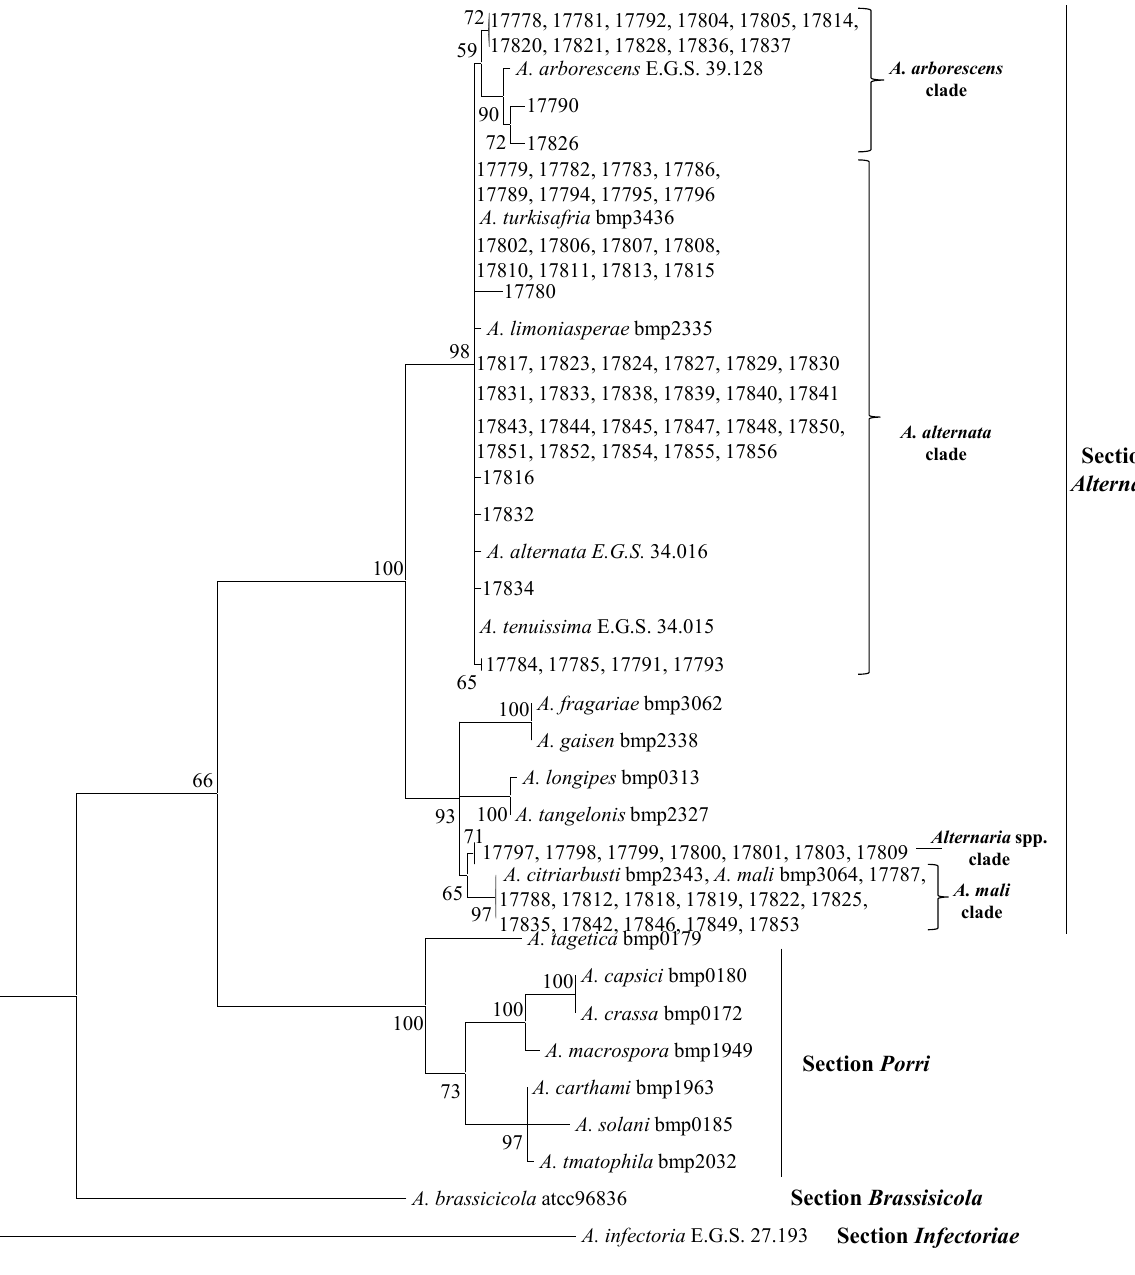
Figure 2. Phylogenetic tree generated by the Maximum Likelihood method (bootstrap 1,000 replicates) of combined alt-a1 , gpd , and tef gene sequences from 79 Alternaria strains isolated from Cakile maritima in Tunisia. Alternaria infectoria E.G.S.27.193 was used as outgroup in